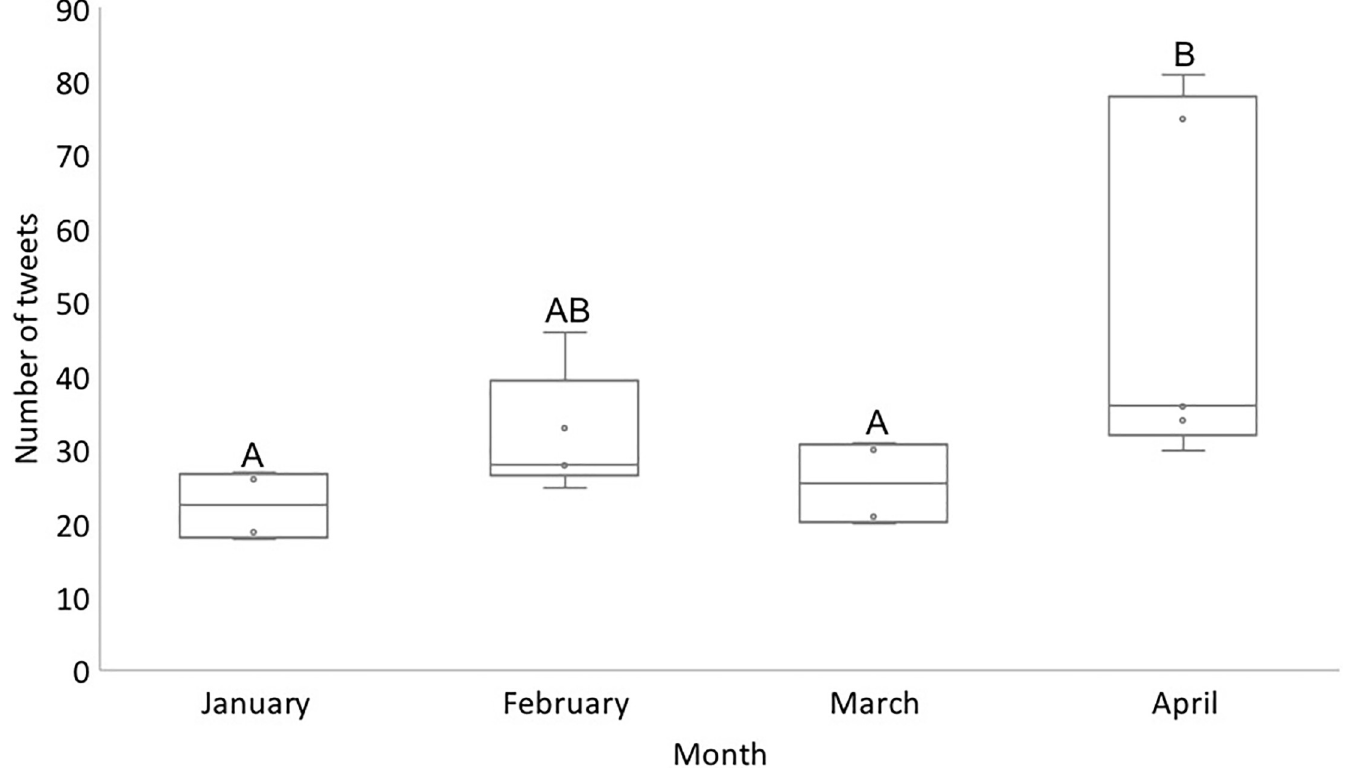
Fig 3. Number of tweets published by month indicating someone wanting to own a pet lemur (with weeks as replicates). Letters indicate significant differences. The boxes highlight the quartiles while the whiskers indicate the variability outside the outer quartiles.